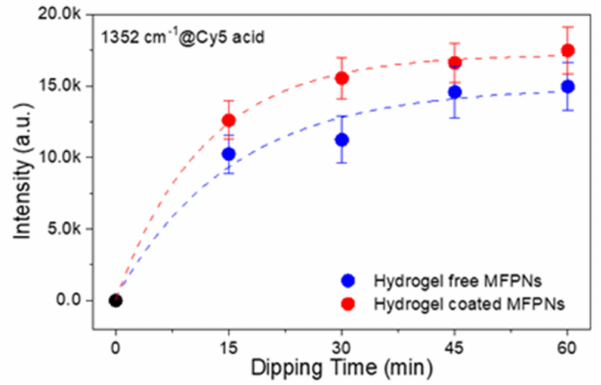
Figure 4. Variations of the Raman intensity at 1352 cm − 1 of 10 µ M Cyanine5 (Cy5) acid on metal film (Au/Ag) over polyimide (PI) nanopillars (MFPNs) with and without the hydrogel layer, plotted as a function of the dipping